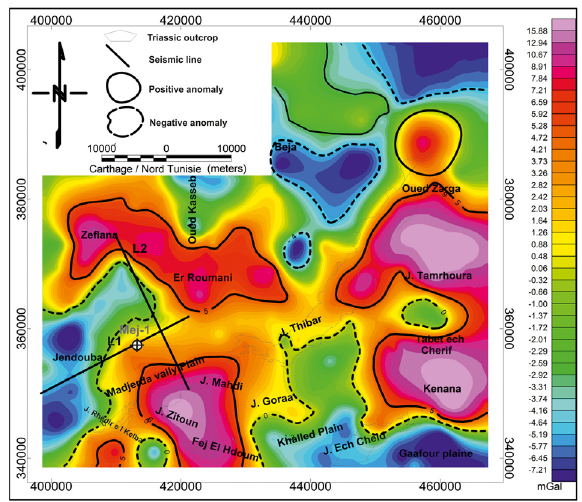
Figure 7. Residual gravity anomaly map of the Thibar area (north- ern Tunisian